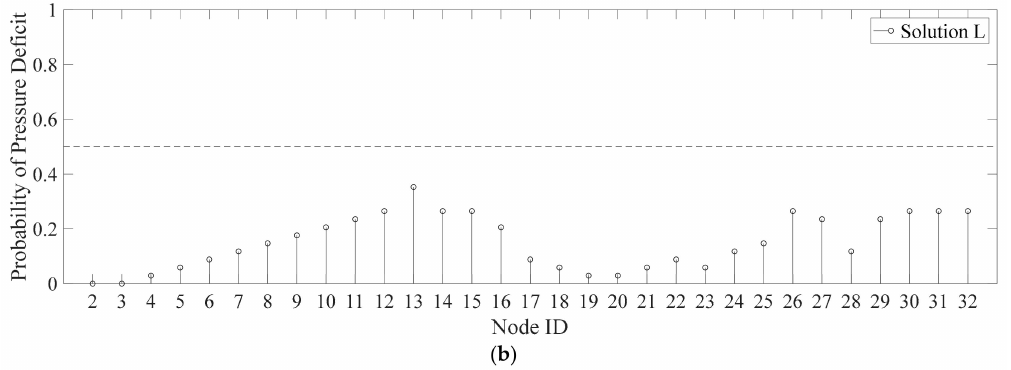
Figure 8. Probabilities of nodal pressure deficit associated with Solutions H and L. ( a ) Solution H; ( b ) Solution